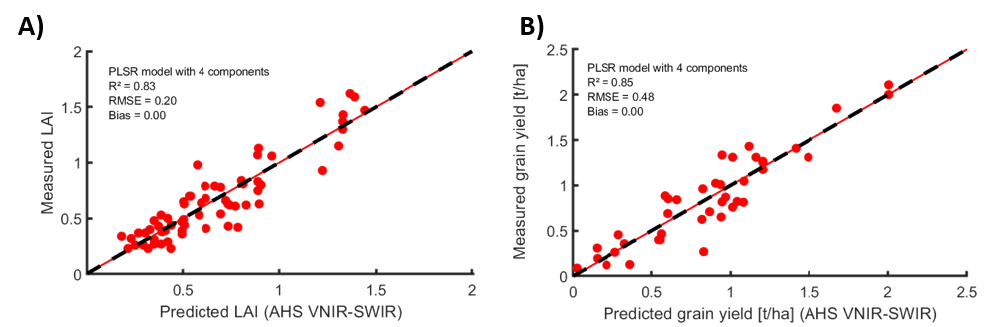
Figure 7. Measured versus predicted LAI and grain yield based on PLS regression using AHS VNIR – SWIR data: ( A ) LAI (n = 64) and ( B ) grain yield (n = 40).